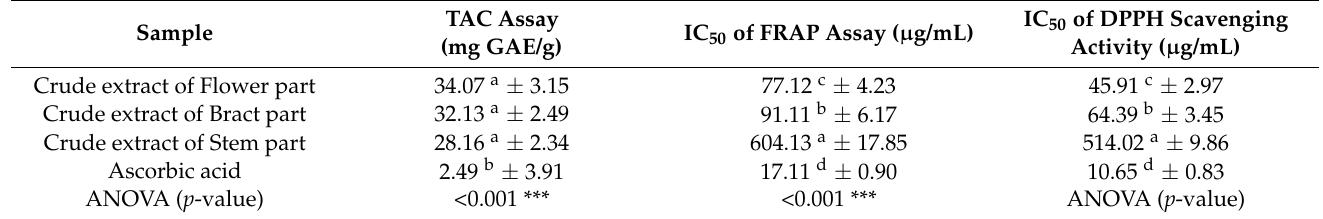
Table 1. Total antioxidant capacity, ferric reducing antioxidants power, and DPPH radical scavenging assays of flower, bract, and stem of C. scolymus L.